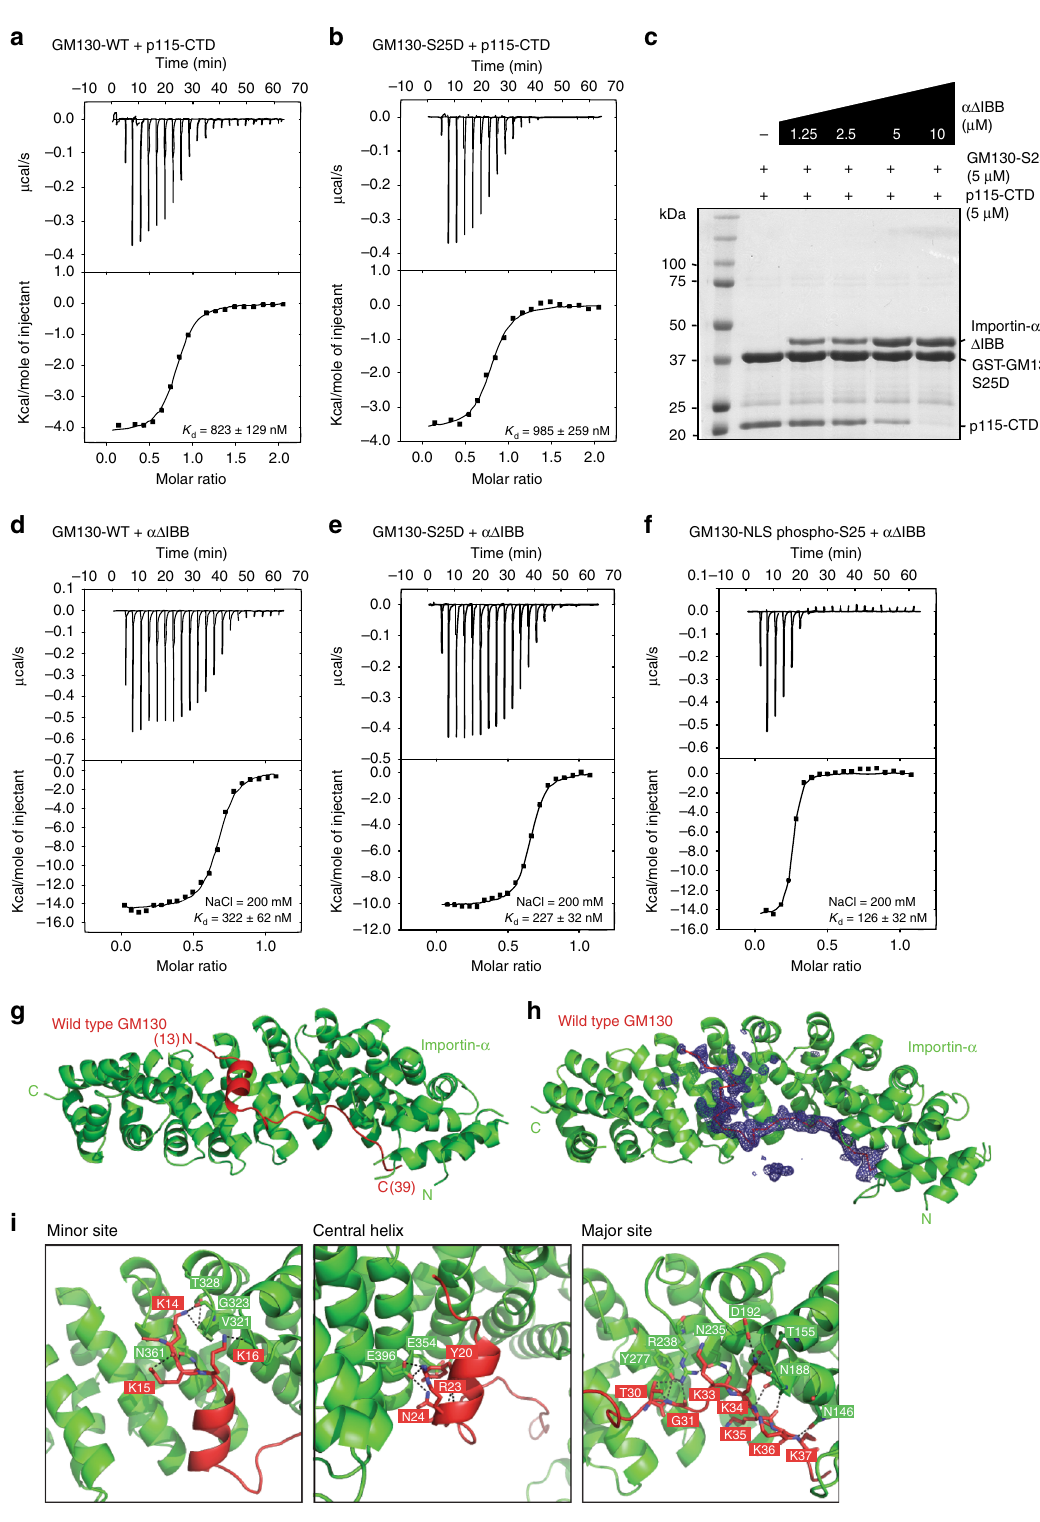
Fig. 1 Biochemical and structural characterization of the GM130 and Importin- α interaction. a , b ITC titration curves (upper) and binding isotherms (lower) of p115-CTD with GM130-WT ( a ) and GM130-S25D ( b ). K d values are indicated. c Competition binding assay. GST-GM130-S25D and p115-CTD were incubated with the indicated concentrations of Importin- α ( Δ IBB). Samples pulled down by GST beads were analyzed by SDS – PAGE and stained with Coomassie blue. d – f ITC titration curves (upper) and binding isotherms (lower) of Importin- α ( Δ IBB) with GM130-WT ( d ), GM130-S25D ( e ), and GM130- NLS phospho-S25 ( f ). Salt concentration and K d values are indicated. g Cartoon representation of the GM130 (a.a. 1 – 48) (cid:129) Importin- α (a.a. 70 – 498) complex, showing GM130 in red and Importin- α in green. Residues 13 – 39 in GM130 are assigned. h An omit difference (Fo – Fc) map contoured at 2.5 sigma with a superimposed atomic model of the GM130-NLS WT (cid:129) Importin- α complex. GM130 and Importin- α are displayed as ribbons (red) and cartoons (green), respectively. i The three panels highlight the interactions at the minor binding site (left), central α -helix (middle) and major binding site